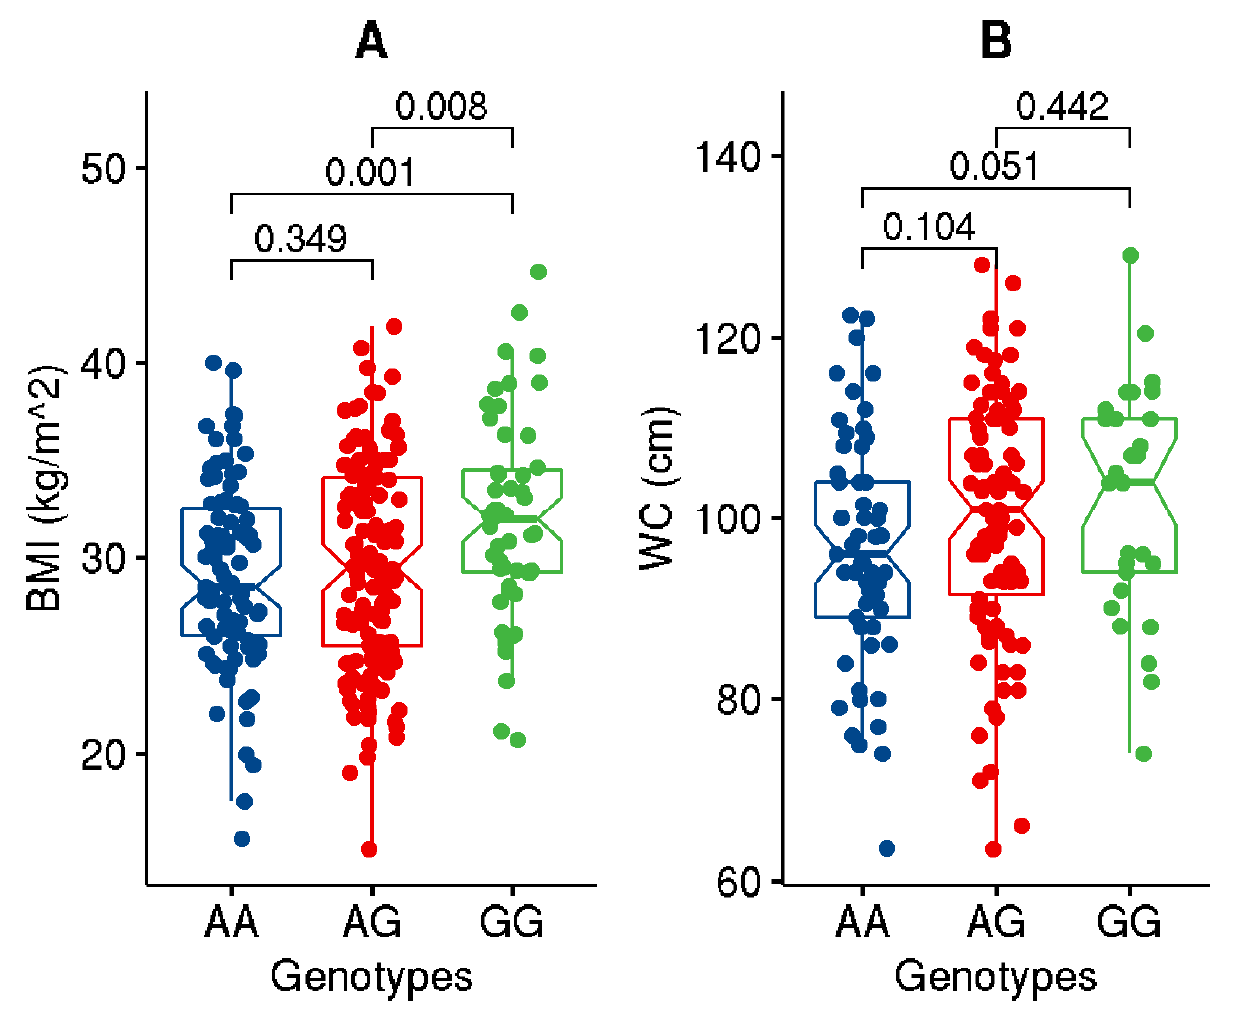
Figure 1. Data distribution for the levels of BMI ( A ) and WC ( B ) in individuals with genotypes homozygous for major allele (AA) versus genotypes homozygous for effect allele (GG) or for the heterozygous genotypes (AG). The boxplot illustrates minimum and maximum values in the range, first quartile, median, and third quartile for each of the genotype groups.